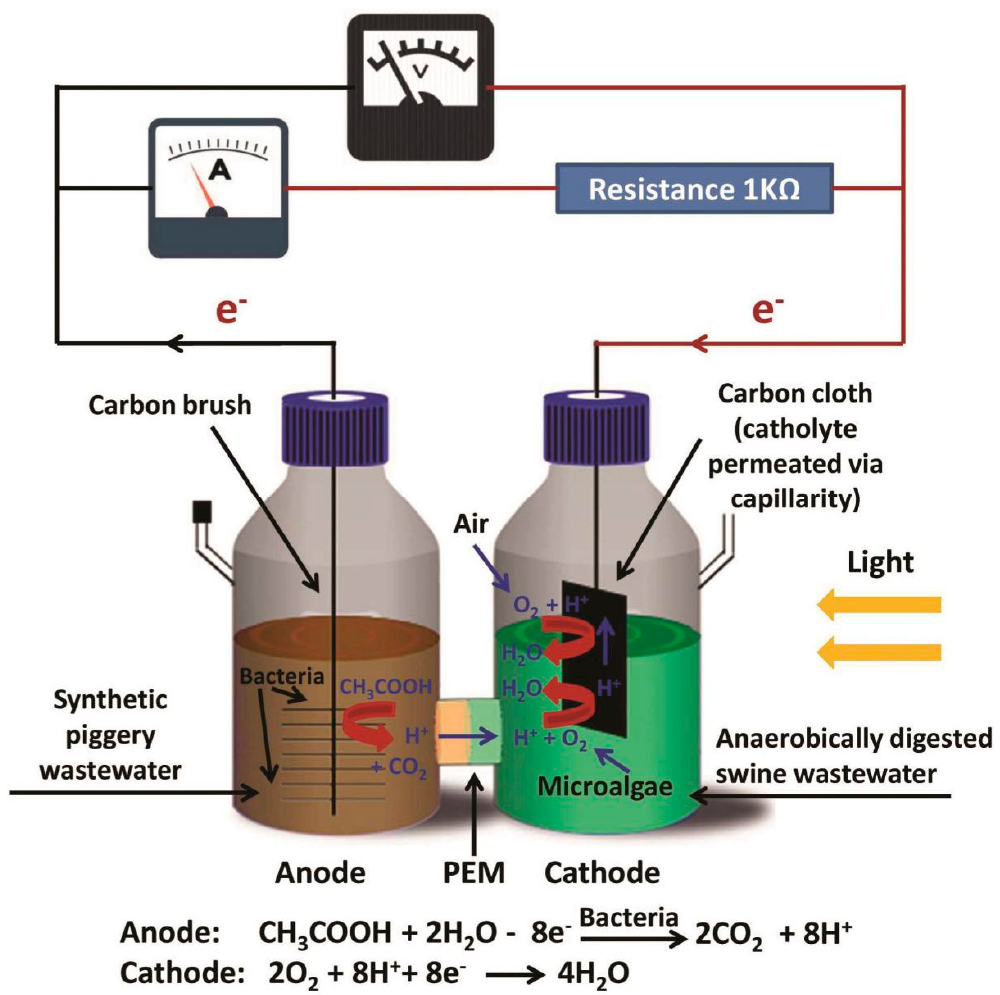
Figure 1. Configuration of the microbial fuel cell (MFC) reactor.